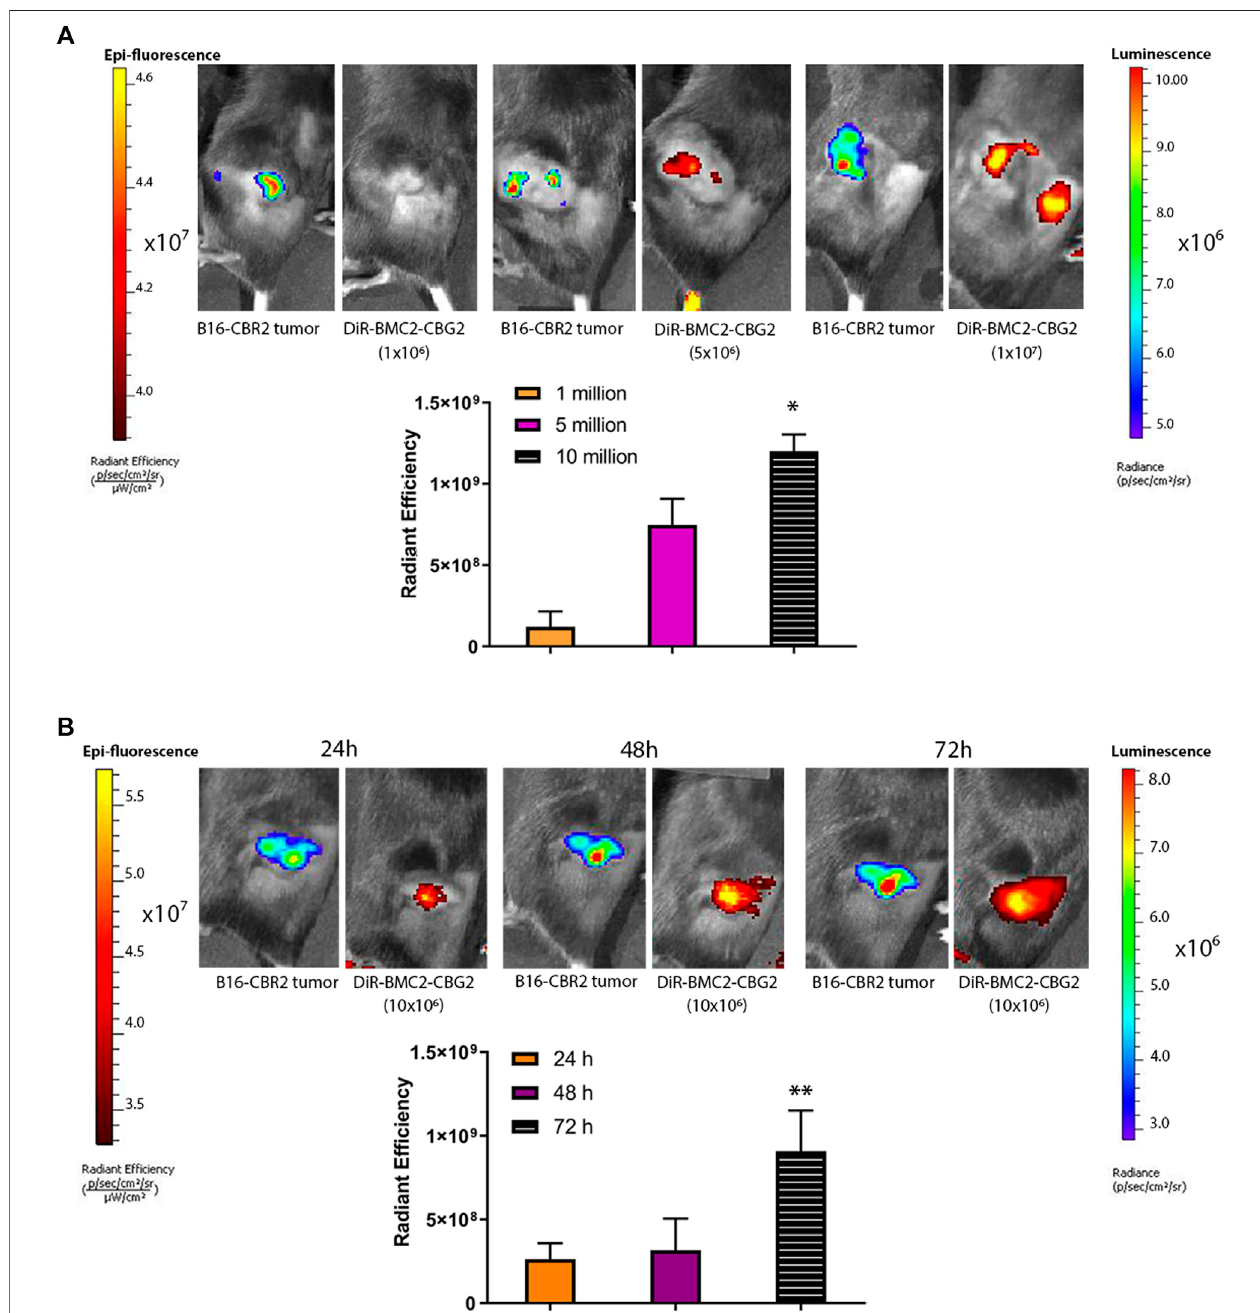
FIGURE2| BMC2-CBG2macrophagesforsubcutaneousmelanomadetection. (A) MiceweretransplantedwithasubcutaneousB16F10melanomatumormodel engineered to express near-infrared CBR2 click beetle luciferase (B16-CBR2). Bioluminescence photon fl uxes represent the light emission for B16-CBR2 melanoma beforeBMC2-CBG2administration.BLimageswereacquired15 minafterNH 2 -NpLH2substrateinjection.Beforesystemicinjection,BMC2-CBG2macrophageswere pre-labeledwiththeDiRnear-infrareddye(excitation710 nmandemission760 nm)attheamountof1,5,and10millionpermouse( n =3mice).Respectiveradiant ef fi ciencieswerequanti fi edandplotted.Thebargraphshowsthemean fl uorescenceintensity,andsigni fi cancewasregisteredformeanvaluesofthe1-milliongroupand mean values of the 10-million group. (*) p values ( p < 0.05) were calculated by one-way ANOVA followed by Tukey ’ s test for multiple comparisons. Error bars represent ±SD. (B) FluorescencevaluesofBMC2-CBG2macrophagespre-labeledwiththeDiRnear-infrareddye( fi ltersselectedforexcitationat710 nmandemissionat760 nm) injected systemically at a dose of 10 million cells per mouse. Fluorescence image acquisition was performed at 24, 48, and 72 h after BMC2-CBG2 macrophage administration. The respective radiant ef fi ciencies were quanti fi ed and plotted. Bioluminescence photon fl uxes represent the light emission for B16-CBR2 melanoma beforeBMC2-CBG2 macrophage administrations. BLimages wereacquired 15 min after NH 2 -NpLH2 substrate injection. Thebar graph showsthe mean fl uorescence intensity ( n = 3 mice). Signi fi cance was registered for mean values of 24- and 48-h groups versus mean values of the 72-h group. (*) p < 0.05. Error bars represent ±SD.